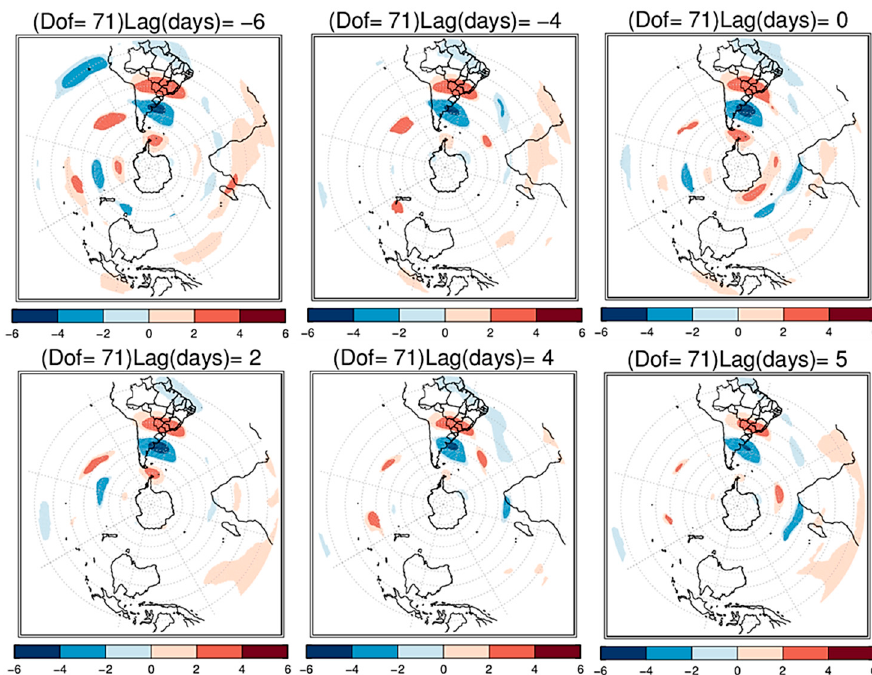
Figure 15. Lag composite of intraseasonal anomalies of the zonal wind (m/s) at 200 hPa during SACZ events at AAO+. Shaded areas in red (blue) are for the positive (negative) values statistically significant at the 5% level, based on Student’s t -test. Dof is the degrees of freedom.